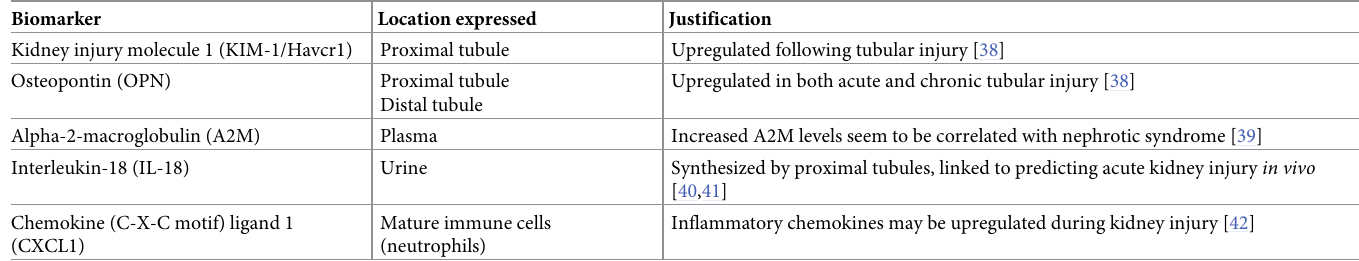
Table 5. Injury biomarker selection and